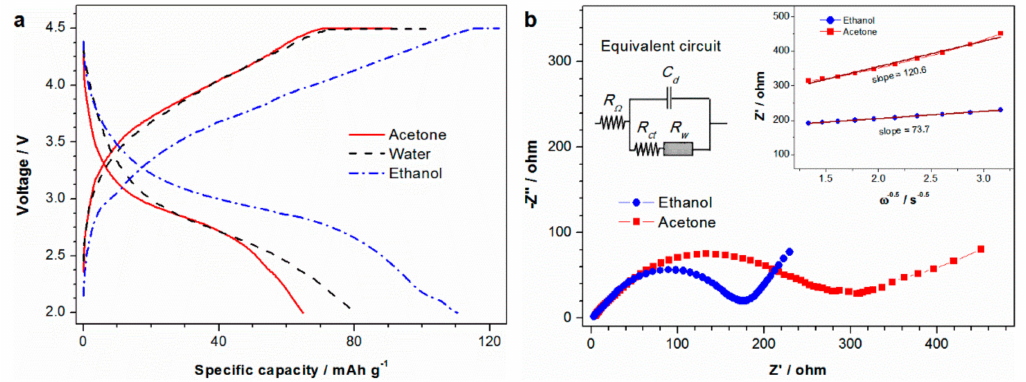
Figure 3. ( a ) Typical charge / discharge curves and ( b ) Nyquist plots (inset: the linear fitting of Z (cid:48) versus ω − 1 / 2 relationship)ofLiMnBO 3